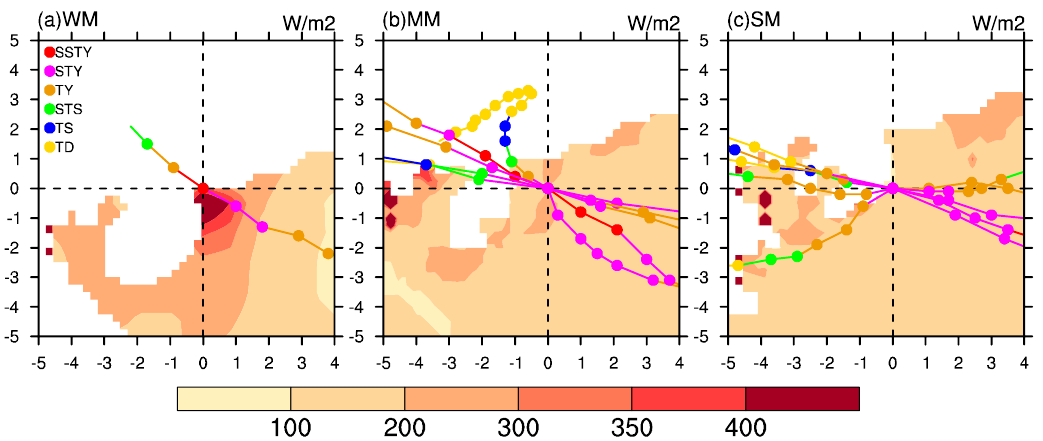
Figure 11. Same as in Figure 10, but for enthalpy heat flux. ( a ) Cluster WM, ( b ) cluster MM, ( c ) and cluster SM. Units: W m − 2 .